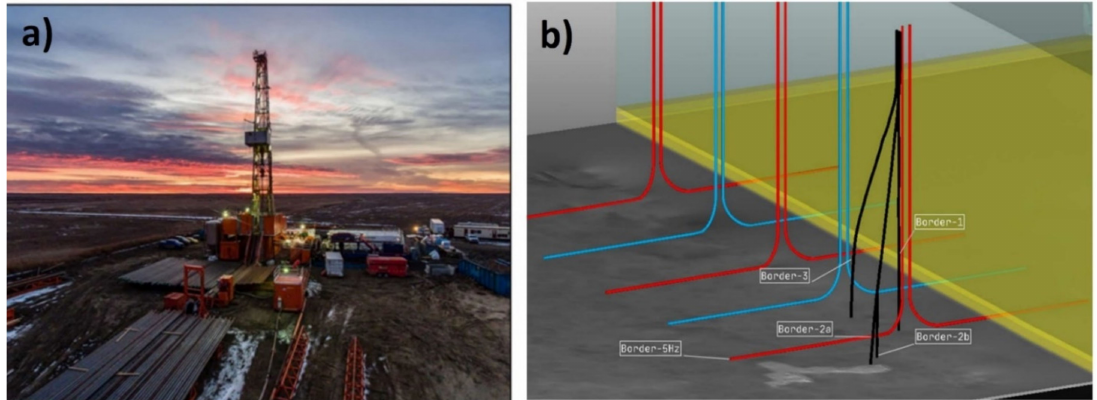
Figure 10. ( a ) Drilling rig for the DEEP project and ( b ) schematic representation of drilled wells